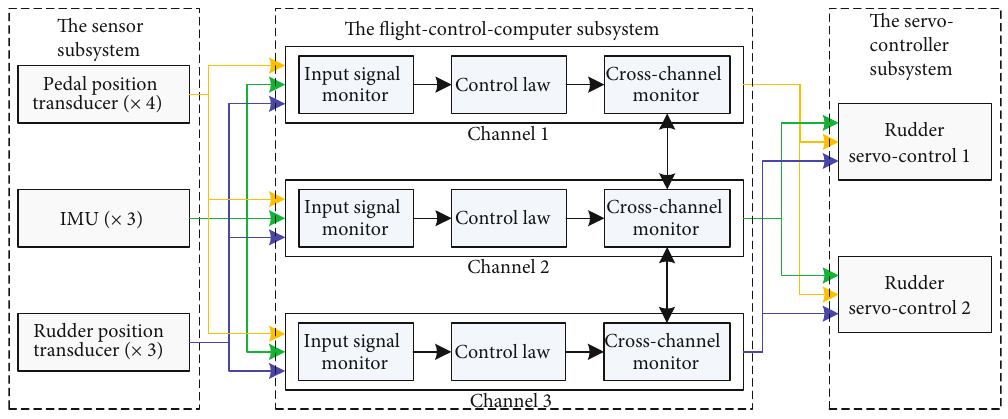
Figure 9: The architecture of the rudder control